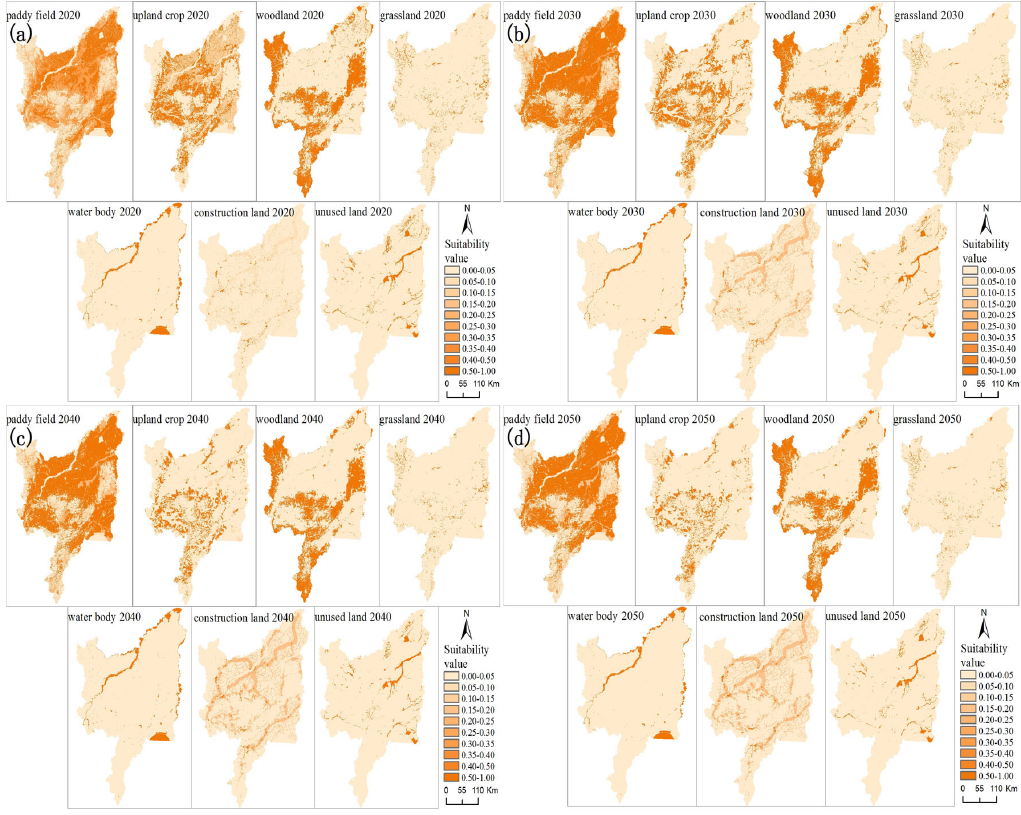
Figure 5. Suitability images of each land cover type in the epochs of 2020, 2030, 2040, and 2050. ( a ) 2020; ( b ) 2030; ( c ) 2040; and ( d ) 2050.